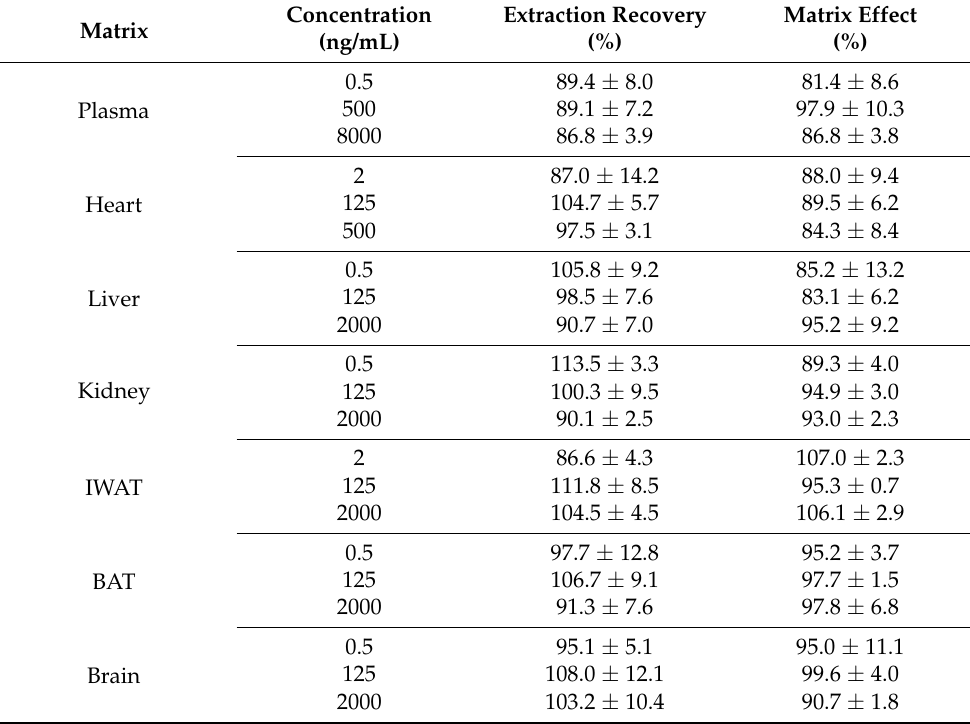
Table 4. Recoveries and Matrix effects of 13 C 4 SA in mouse plasma and tissues (mean ± SD, n = 5). Concentration Matrix